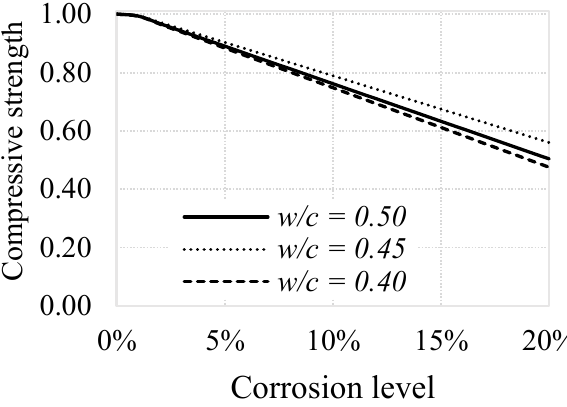
Figure 6. Compressive strength of concrete cover [29].